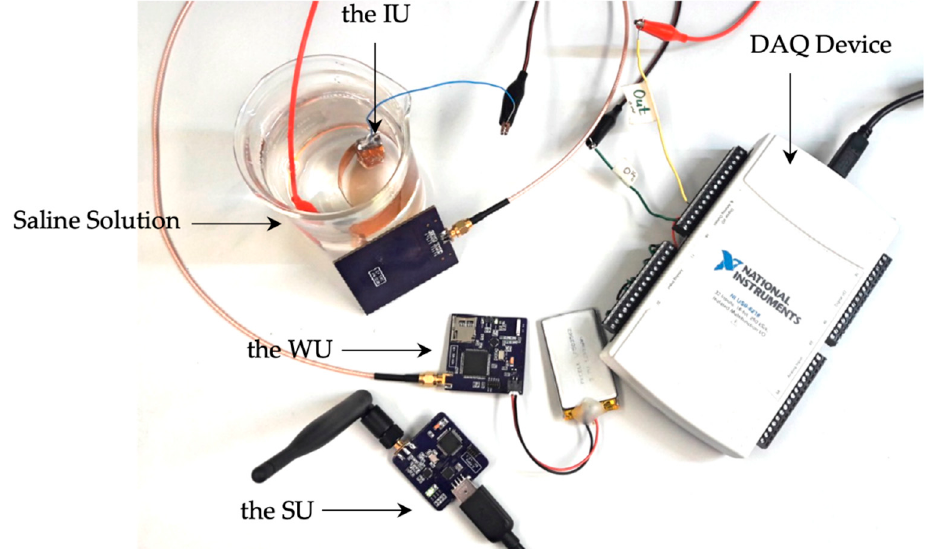
Figure 9. The benchtop setup for the verification of the near field communication recording is shown. A 5-min sample of slow waves recorded in vivo was loaded into a multifunction data acquisition device (DAQ USB-6218, National Instrument) and streamed into the implantable unit through saline solution. The signals were then recorded, sent to the wearable unit through the inductive link and wirelessly transmitted to the stationary unit.